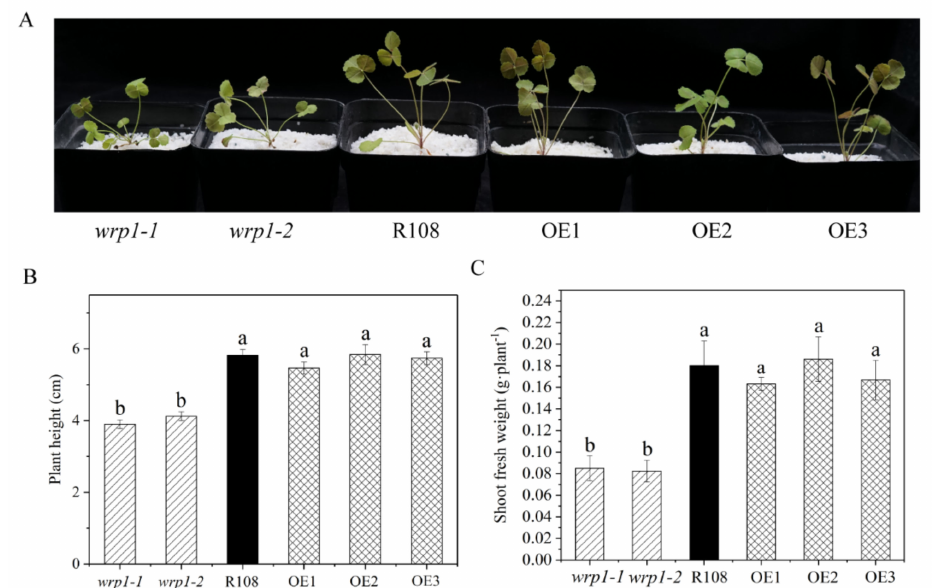
Figure 7. Effects of MtWRP1 on plant growth and development in M. truncatula : ( A ) Growth pheno- type of MtWRP1 mutants ( wrp1-1 and wrp1-2 ), R108 and transgenic M. truncatula (OE1, OE2, and OE3) at 30 days post inoculation with S. mliloti 1021 under nitrogen-deficient conditions. ( B ) The plant heights of MtWRP1 mutants, R108, and transgenic M. truncatula . ( C ) The shoot fresh weights of MtWRP1 mutants, R108, and transgenic M. truncatula . Data represent mean ± SD ( n = four inde- pendent biological replicates). Different letters above the standard error bars indicated a significant difference between the lines as determined by Duncan’s multiple range test ( p <